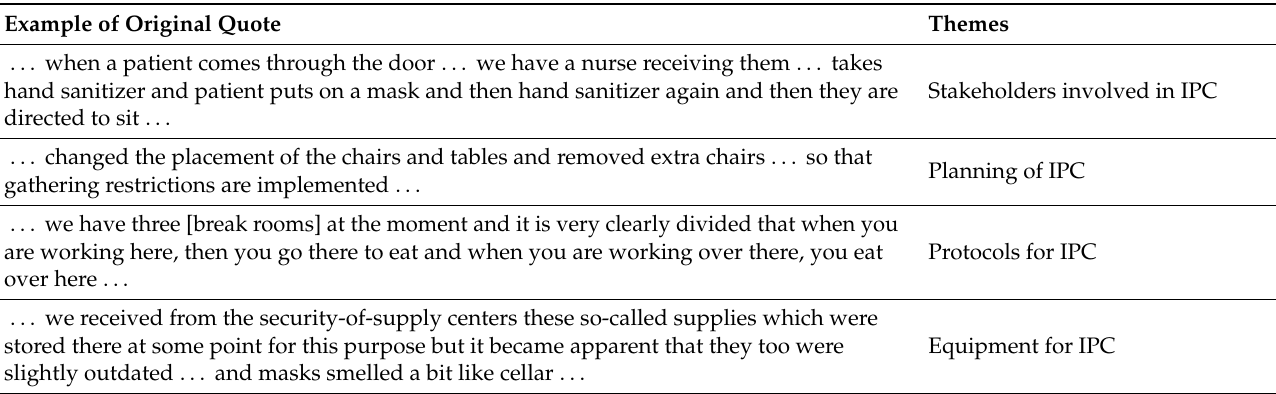
Table 3. Examples of original quotes depicting